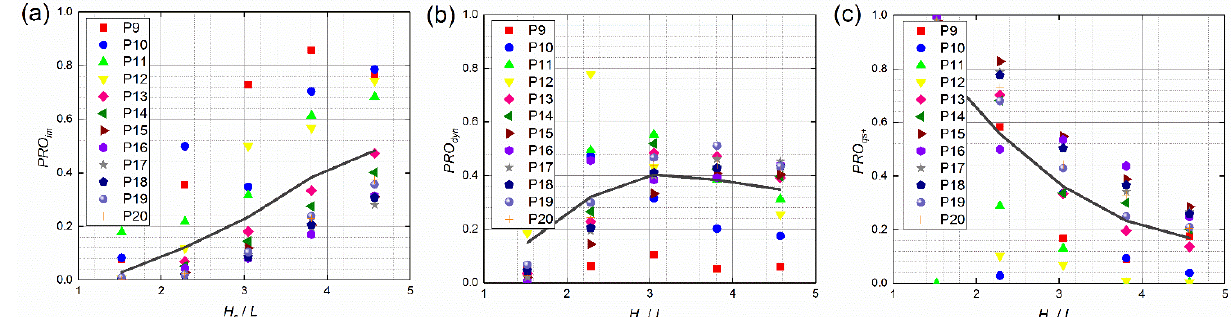
Figure 12. Influence of wave steepness on the probabilities of three types of wave impact on vertical wall for structural clearance of 0.10 m (trials T31 – T35): ( a ) impulsive probability PRO im ; ( b ) dynamic probability PRO dyn ; ( c ) quasi-static probability PRO qs+ .